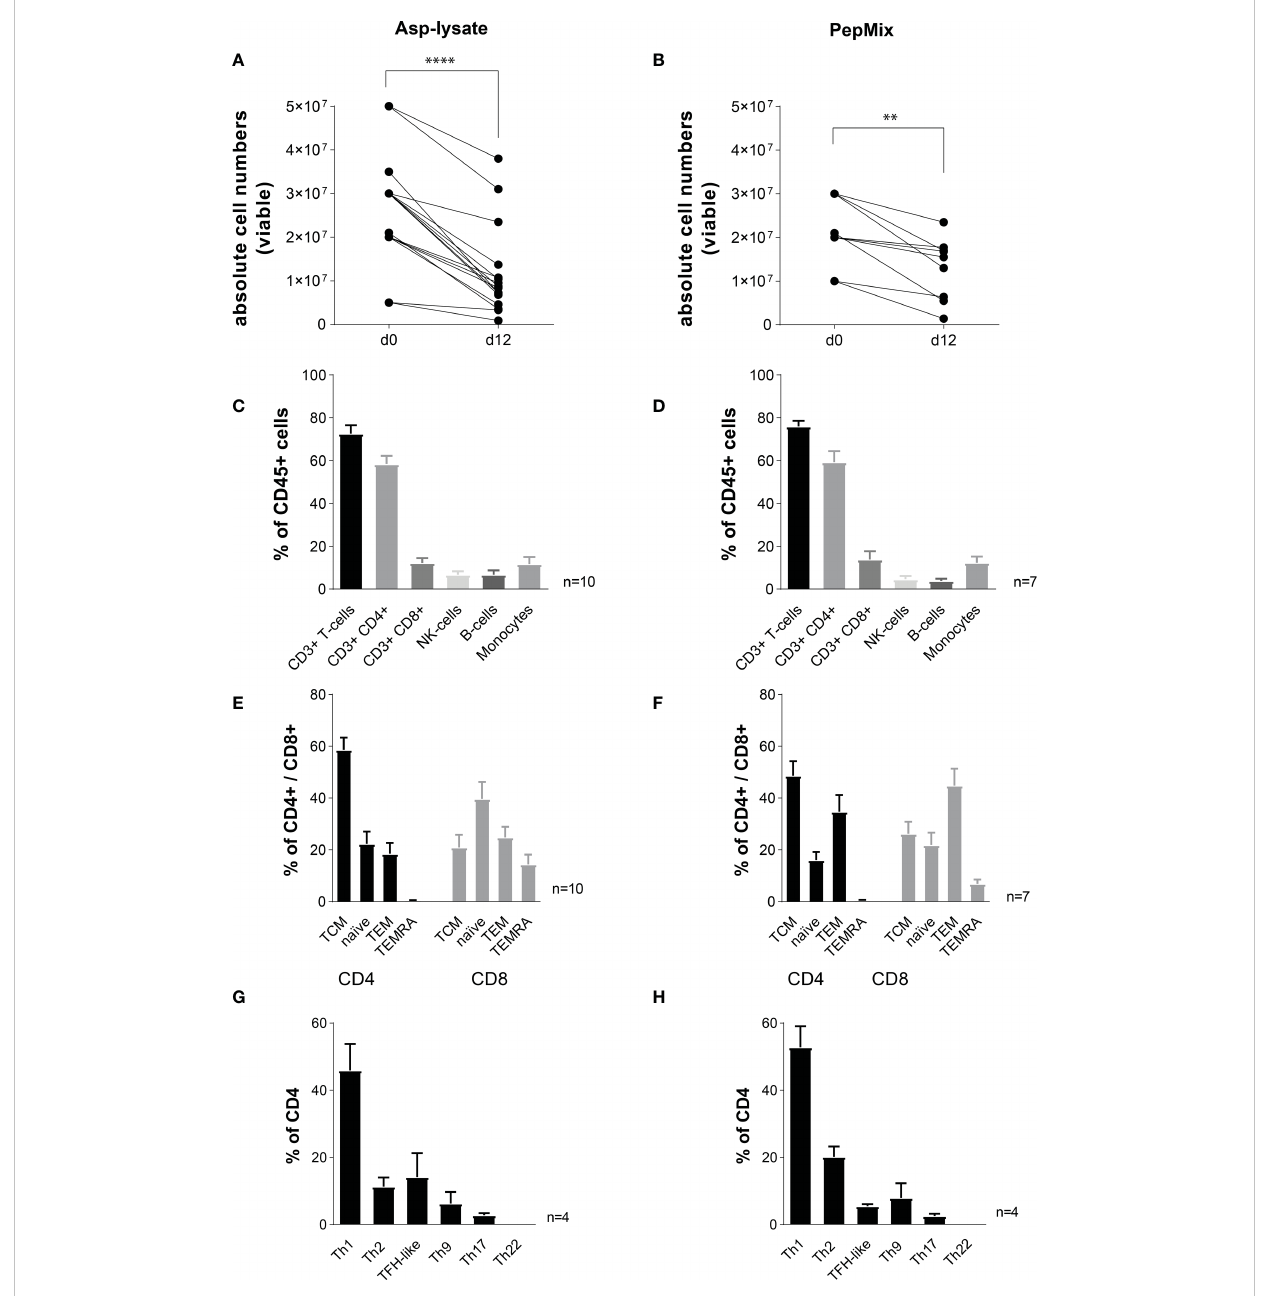
FIGURE 8 Immunophenotyping of short-term expanded seATCs. PBMCs were short-term expanded (STE) for 12 days with either the (A, C, E, G) Asp-lysate (50 µg/ml, n=10) or the (B, D, F, H) PepMix (1 µg per peptide/ml per peptide pool, composed of: CatB, Crf1, f22, Gel1, pmp20, SHMT, SOD and MP65 peptide pool, n=7). Absolute cell numbers per well before (day 0) and after expansion (day 12) for seATCs expanded with (A) Asp-lysate- or (B) PepMix are shown. Statistically signi fi cant difference is indicated by (**p<0.01 and ****p<0.0001). (C, D) Mean proportion of CD3 + , CD4 + and CD8 + seATCs, NK cells, B-cells, and monocytes within CD45 + cells after expansion with (C) Asp-lysate or (D) PepMix are shown as mean±SD. (E, F) Immune phenotypes of CD8 + and CD4 + seATCs and (G, H) CD4 + T-cell subsets, expanded with Apsp-lysate or PepMix are shown as mean±SD. The healthy individuals used belonged to our cohort of donors (n=320) who were pre-tested for the presence of Asp-speci fi c T